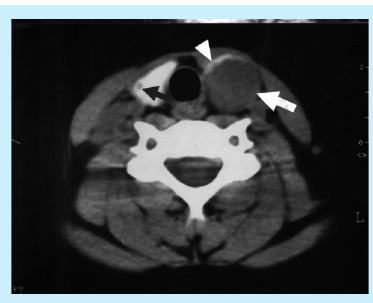
Fig. 2a. Non-contrast CT scan of the neck shows the low-density nodule in the left thy- roid lobe (whte arrow) with a thin rim of normal dense thyroid parenchyma anteriorly (white arrowhead). A small second low-density lesion is demonstrated in the right lobe later- ally (black